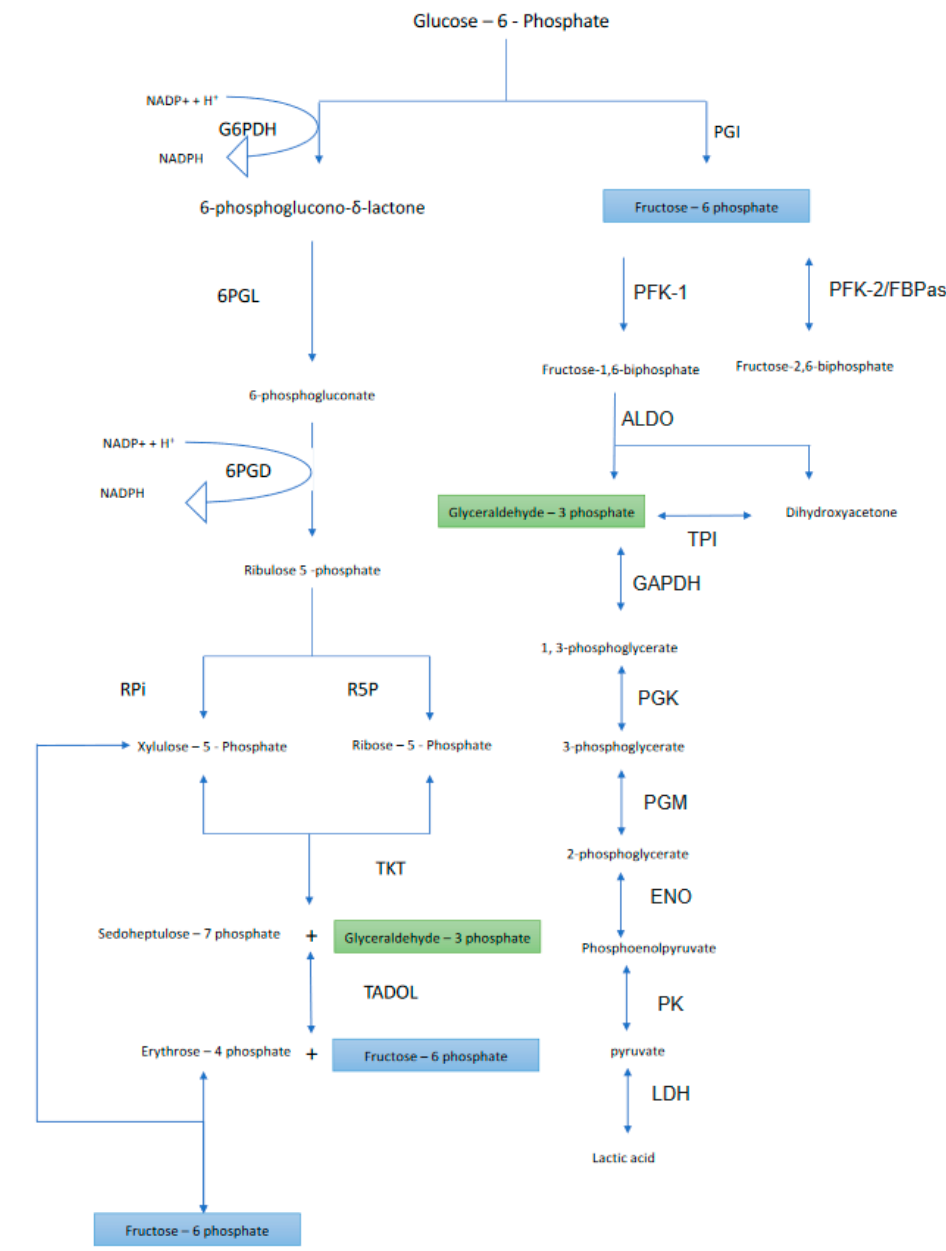
Figure 1. Scheme showing the interaction between glycolysis and PPP.